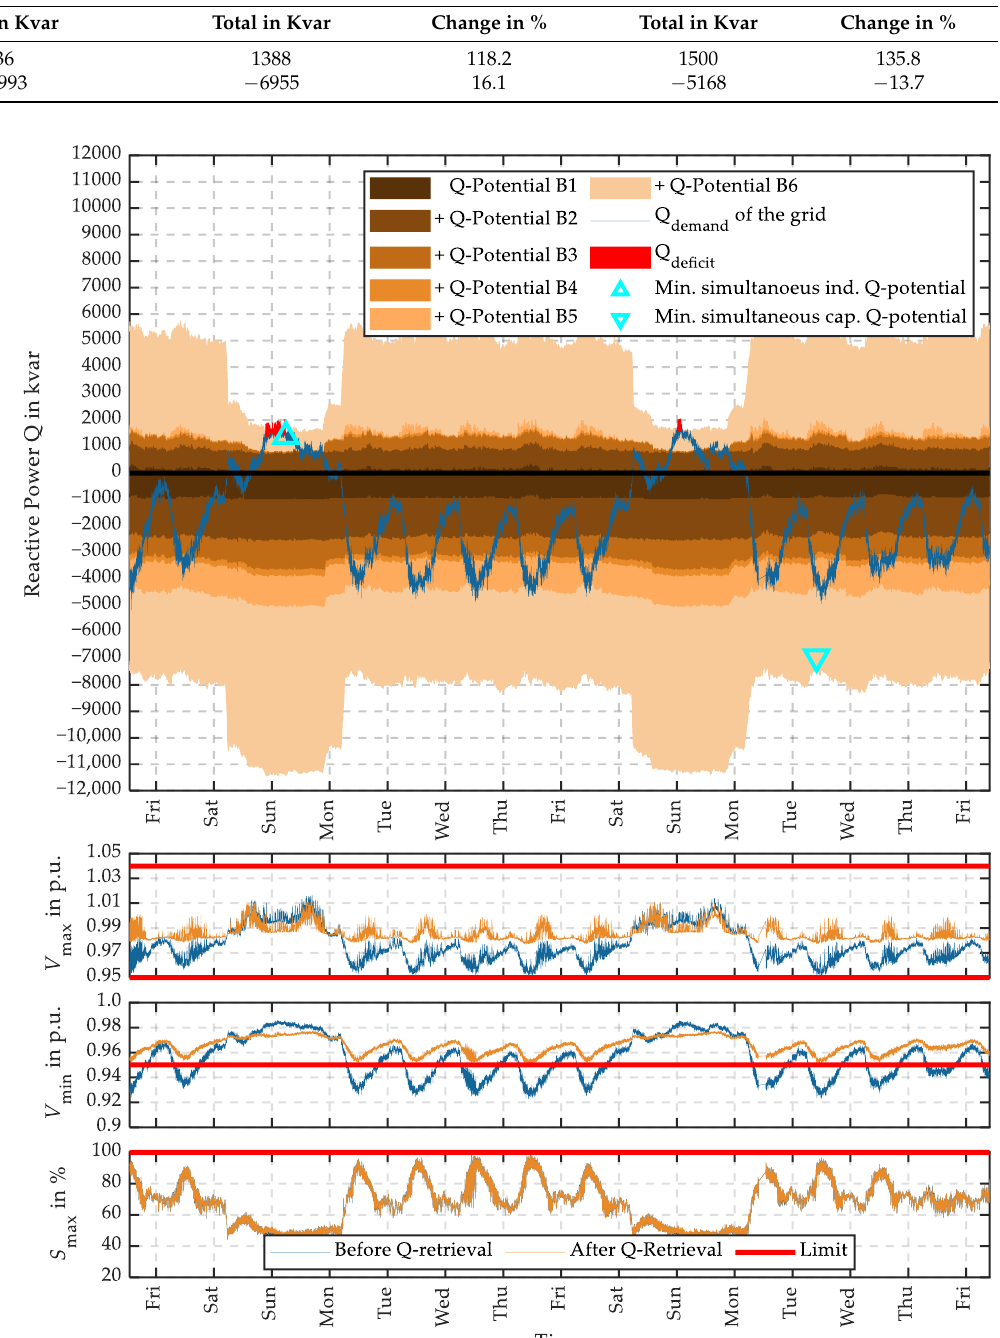
Figure 11. Temporal evolvement of the aggregated reactive power potential of the six industrial companies (brown to orange), the reactive power demand of the grid (blue), the deficient reactive power (red), points in time with the minimal simultaneous inductive and capacitive reactive power potential (cyan triangles) and the presentation of extremes of voltage and load flow progressions before (blue) and after (orange) the application of the control process, with labelling the limitations (red); note: lines in apparent power plots are nearly congruent.